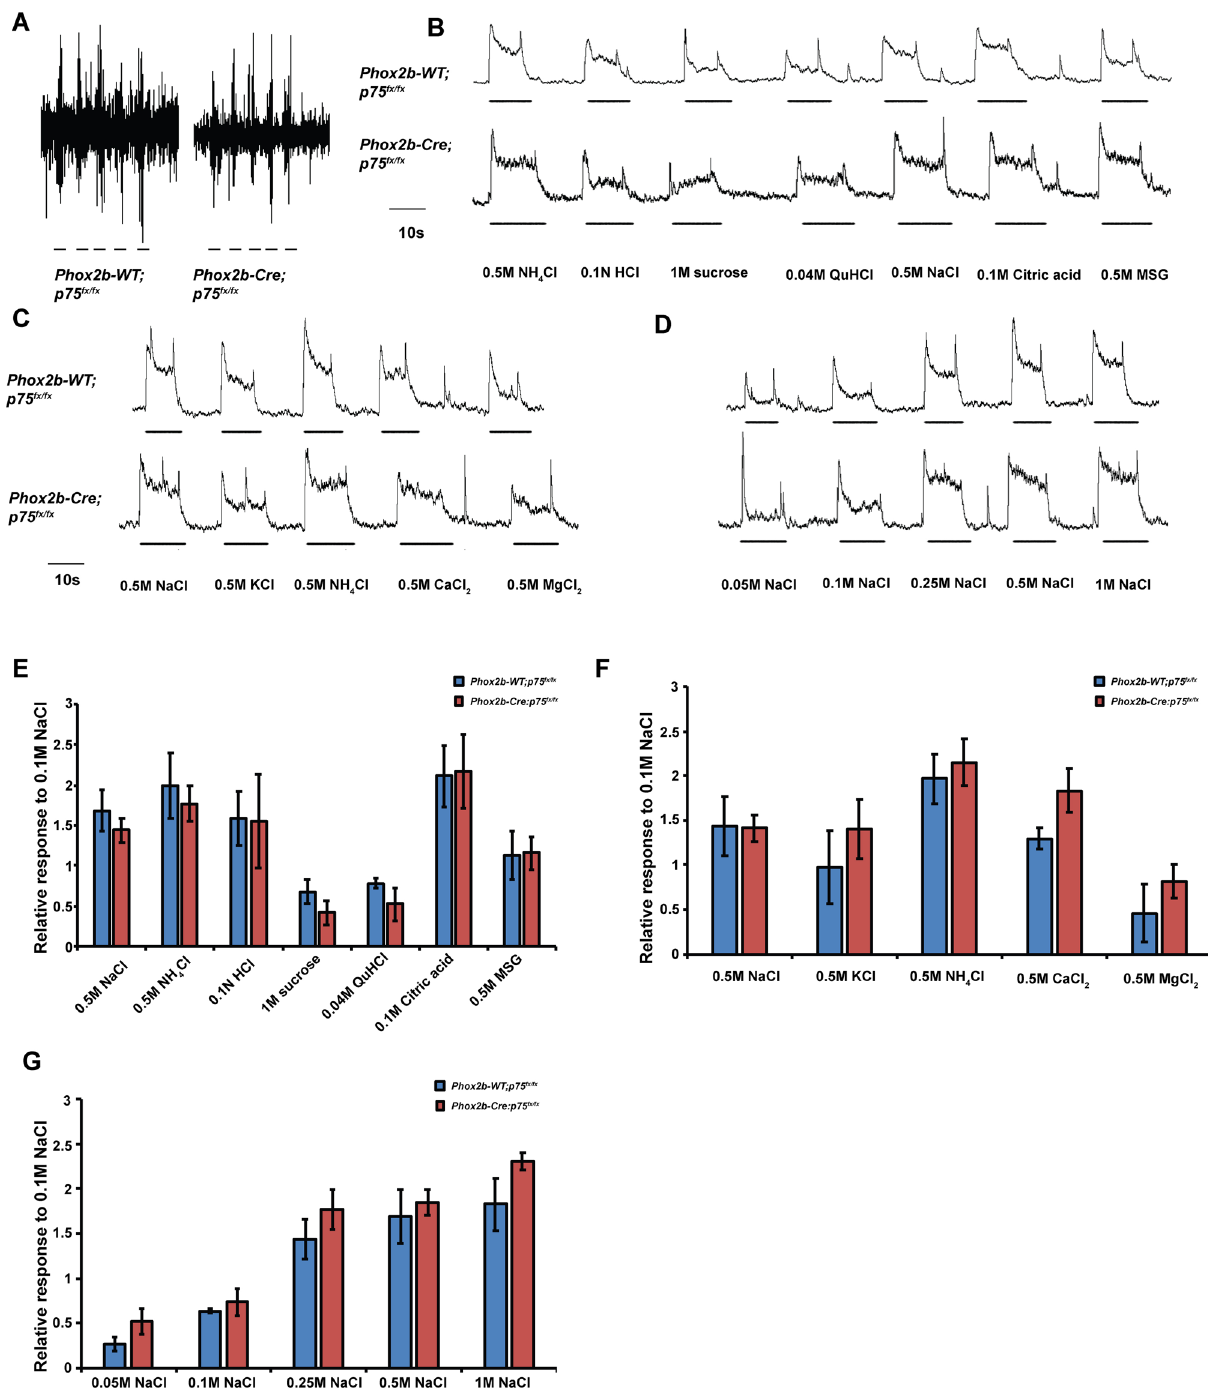
Figure 4. Deletion of p75 in oral sensory geniculate neurons does not affect taste or tactile chorda tympani responses. Representative raw ( A ) or summated ( B – D ) chorda tympani responses to tactile and taste stimuli, respectively, are displayed for Phox2b-WT; p75 fx/fx and Phox2b-Cre; p75 fx/fx mice. Chemical stimuli were quantified and graphed as relative responses compared to 0.1 M NaCl. There were no differences in responses between genotypes to NaCl, NH4Cl, HCl, sucrose, QuHCl, citric acid or MSG ( E ). There were also no differences in responses to chloride salts, or to a dose response curve to NaCl, between Phox2b-WT; p75 fx/fx and Phox2b-Cre; p75 fx/fx mice ( F , G